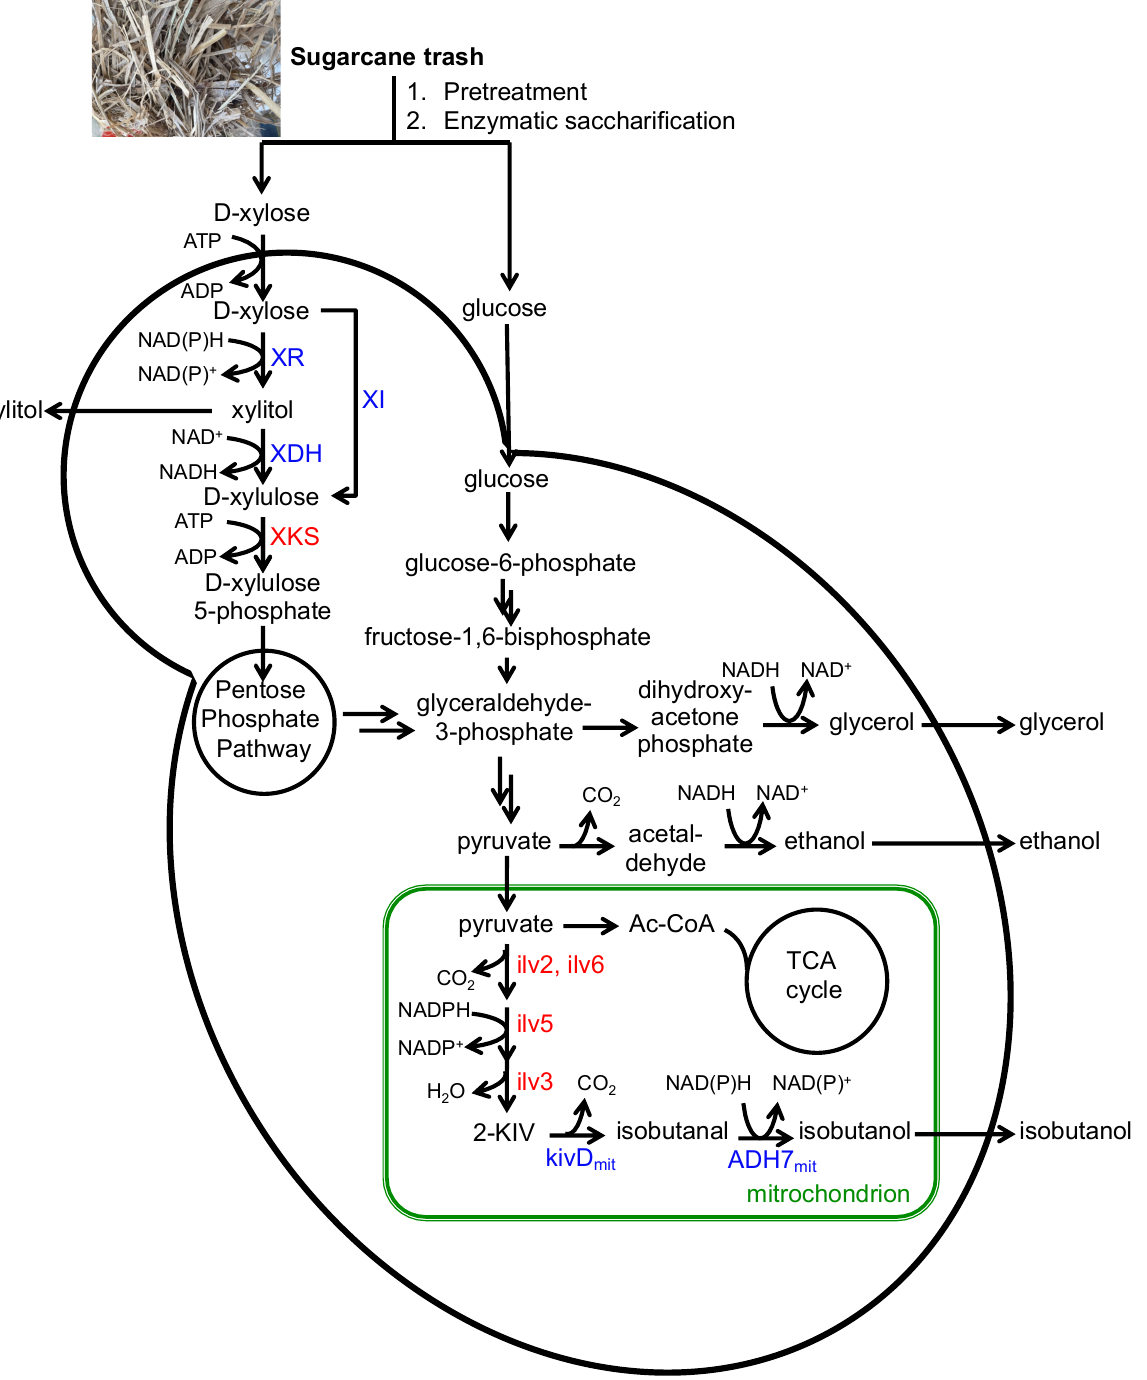
Figure 1. Engineered production of isobutanol from sugarcane trash hydrolysates in P. pastoris . XR xylose reductase, XDH xylitol dehydrogenase, XI xylose isomerase, XKS xylulokinase, Ilv2 acetolactate synthase, Ilv5 acetohydroxyacid reductoisomerase, Ilv3 dihydroxyacid dehydratase, kivD mit mitochondria-targeted keto-acid decarboxylase, ADH7 mit mitochondria-targeted alcohol dehydrogenase. Enzymes highlighted in red are endogenous enzymes. Enzymes highlighted in blue are heterologous